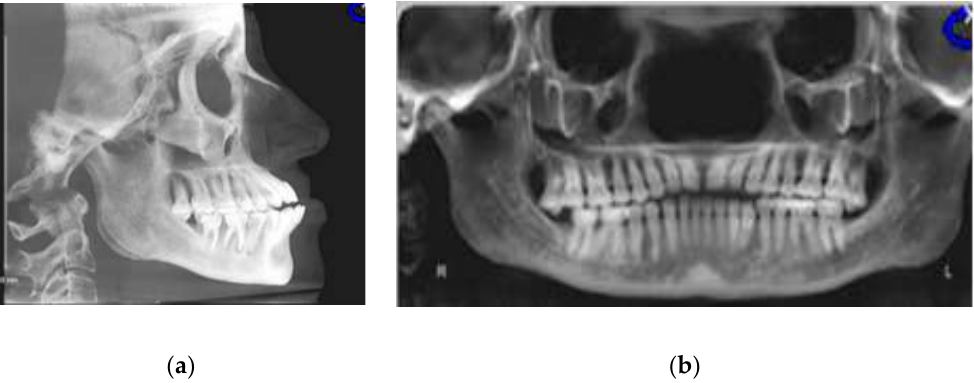
Figure 3. ( a ) CBCT-driven cephalometric radiograph showing anterior cross bite and open bite as well as bimaxillary protrusion; ( b ) CBCT-driven panoramic radiograph showing extra premolar distal to lower left canine and missing lower third molars as well as over erupted upper third molars.